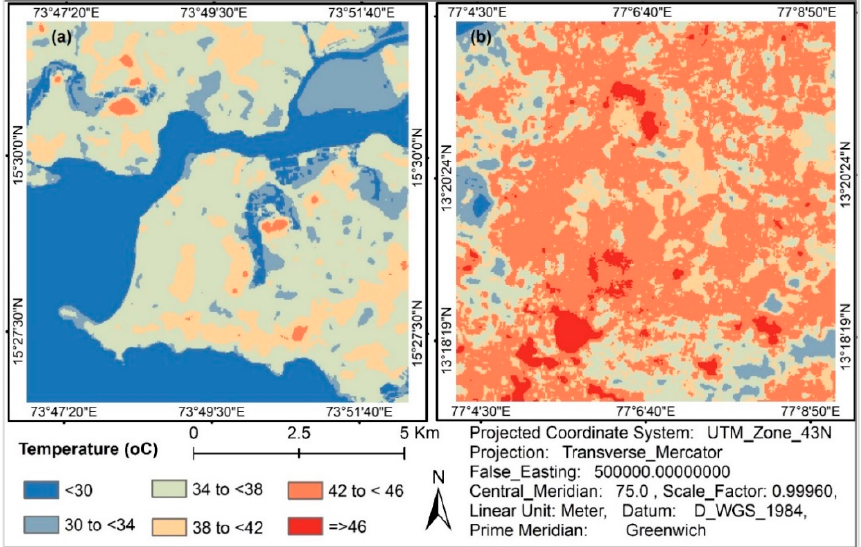
Figure 6. Land Surface Temperature profile of Panaji ( a ) and Tumkur ( b ).